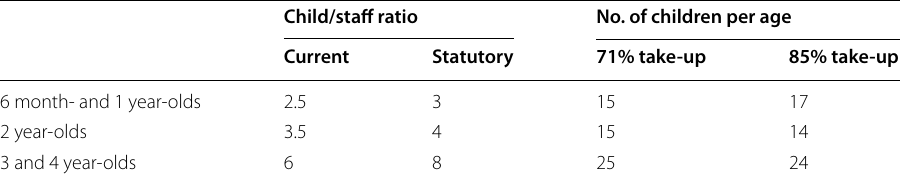
Table 1 Child/staff ratios and distribution of children per facility